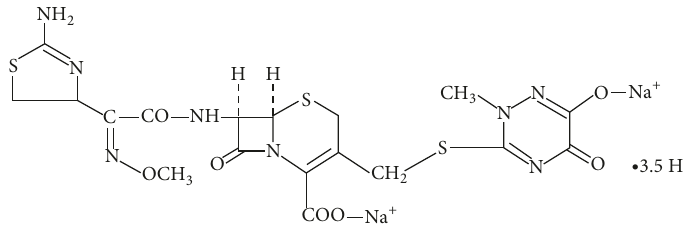
Figure 1: Chemical structure of ceftriaxone sodium (CAS